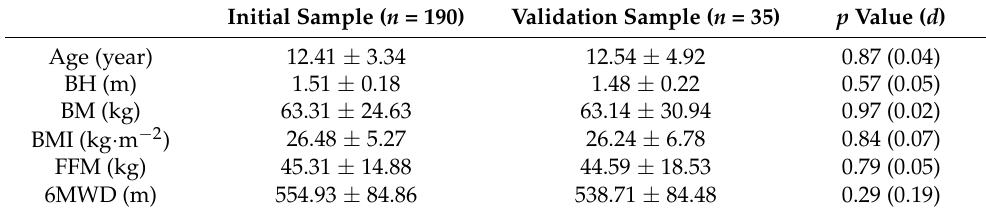
Table 1. Anthropometric and six-minute walk distance characteristics.